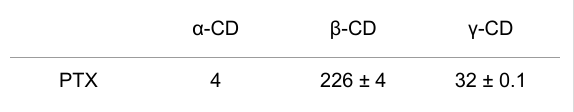
Table 1: The values of binding constants K as [M − 1 ] for PTX with native CDs measured at pH 7.4. α